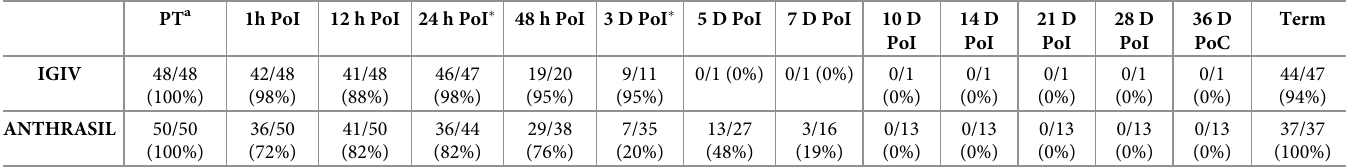
Table 4. Proportion of B . anthracis -infected rabbits bacteremic post-treatment with IGIV or ANTHRASIL. PT a